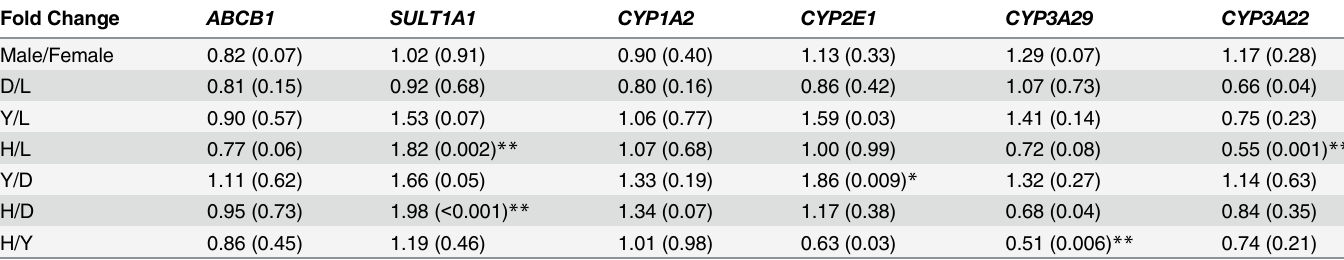
Table 2. Breed and sex fold change (Significance 1 ) comparisons derived from the control animals across target genes.